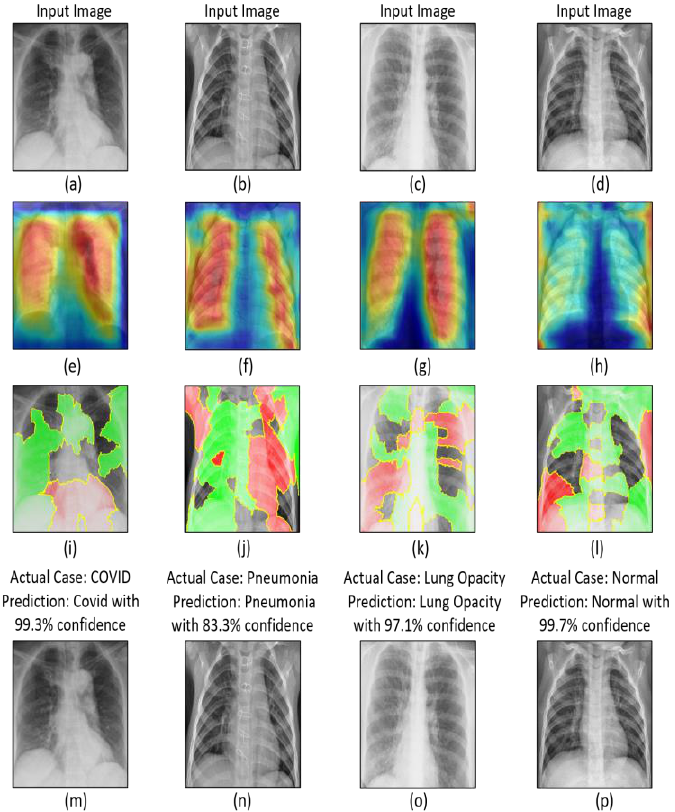
Figure 6. Visualization of significant regions of CNN. ( a ) COVID-19. ( b ) Pneumonia. ( c ) Lung opacity.